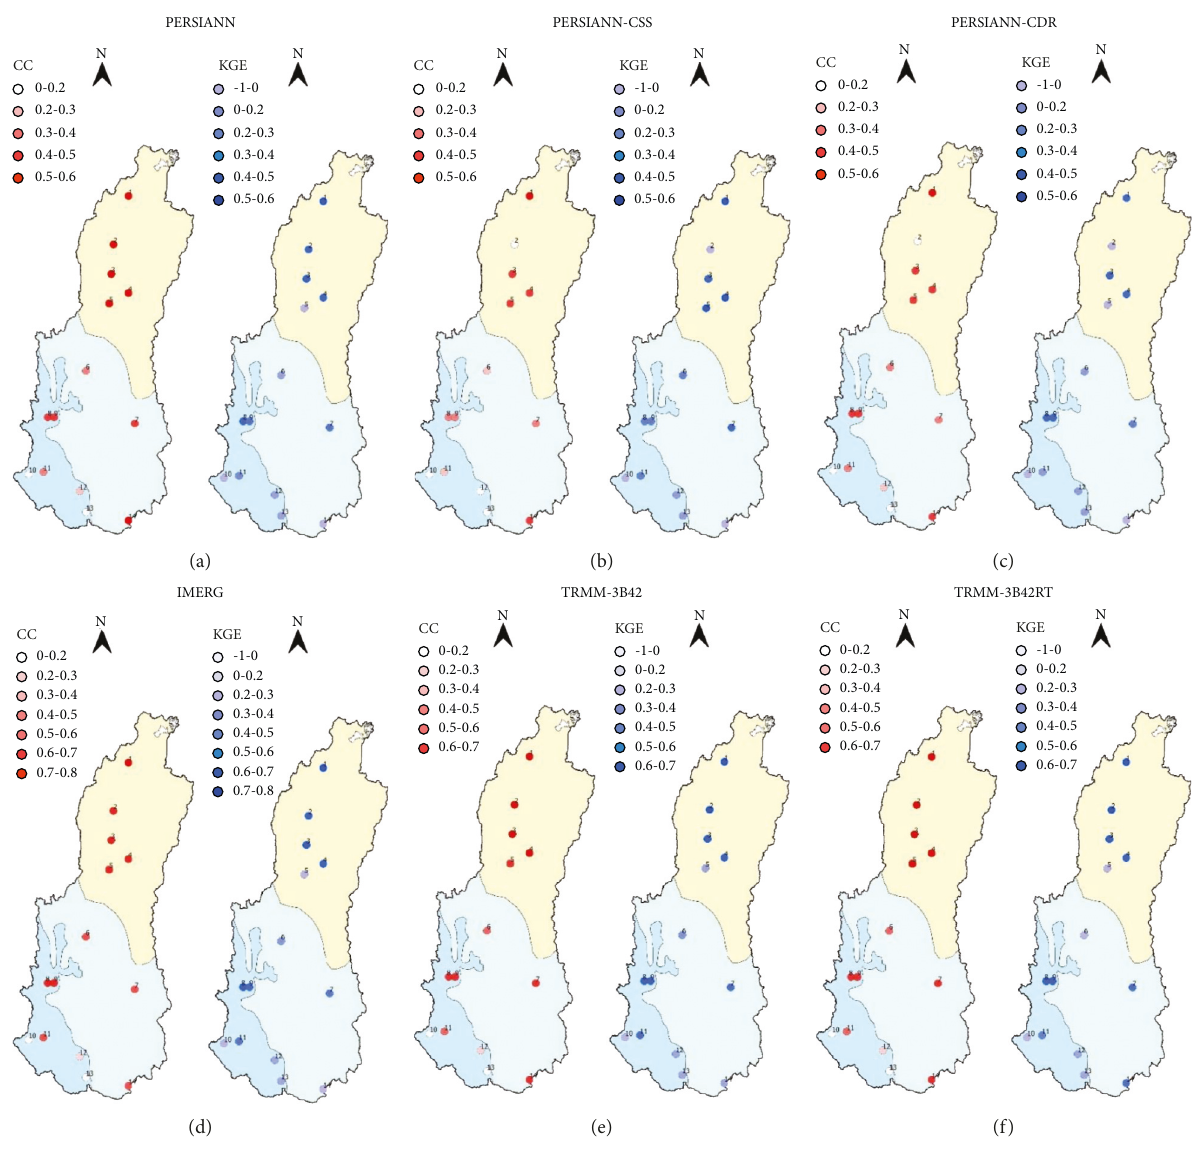
Figure 7: MK and Sen’s Slope results for annual analysis. (a) For Observed rainfall data. (b) For PERSIANN. (c) For PERSIANN-CCS. (d) For PERSIANN-CDR. (e) For IMERG. (f) For TRMM-3B42. (g) For